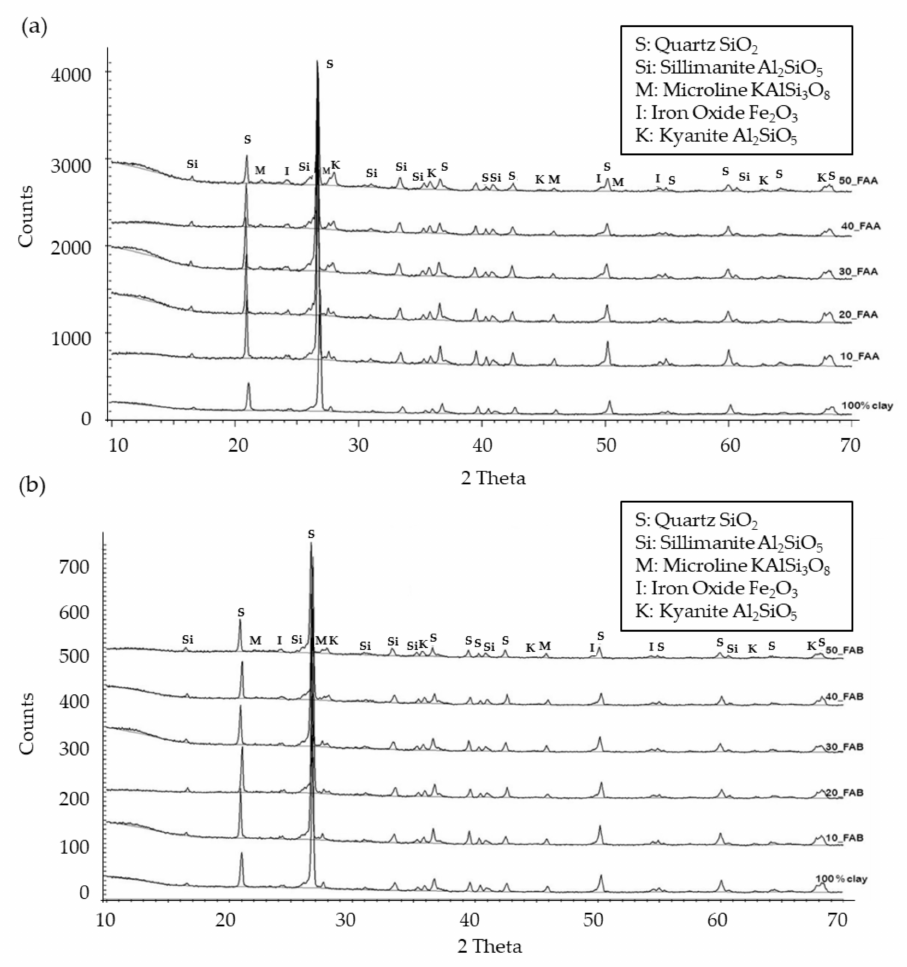
Figure 7. XRD patterns of fired clay bricks prepared from clay B. ( a ) XRD patterns of FAA/clay; ( b ) XRD patterns of